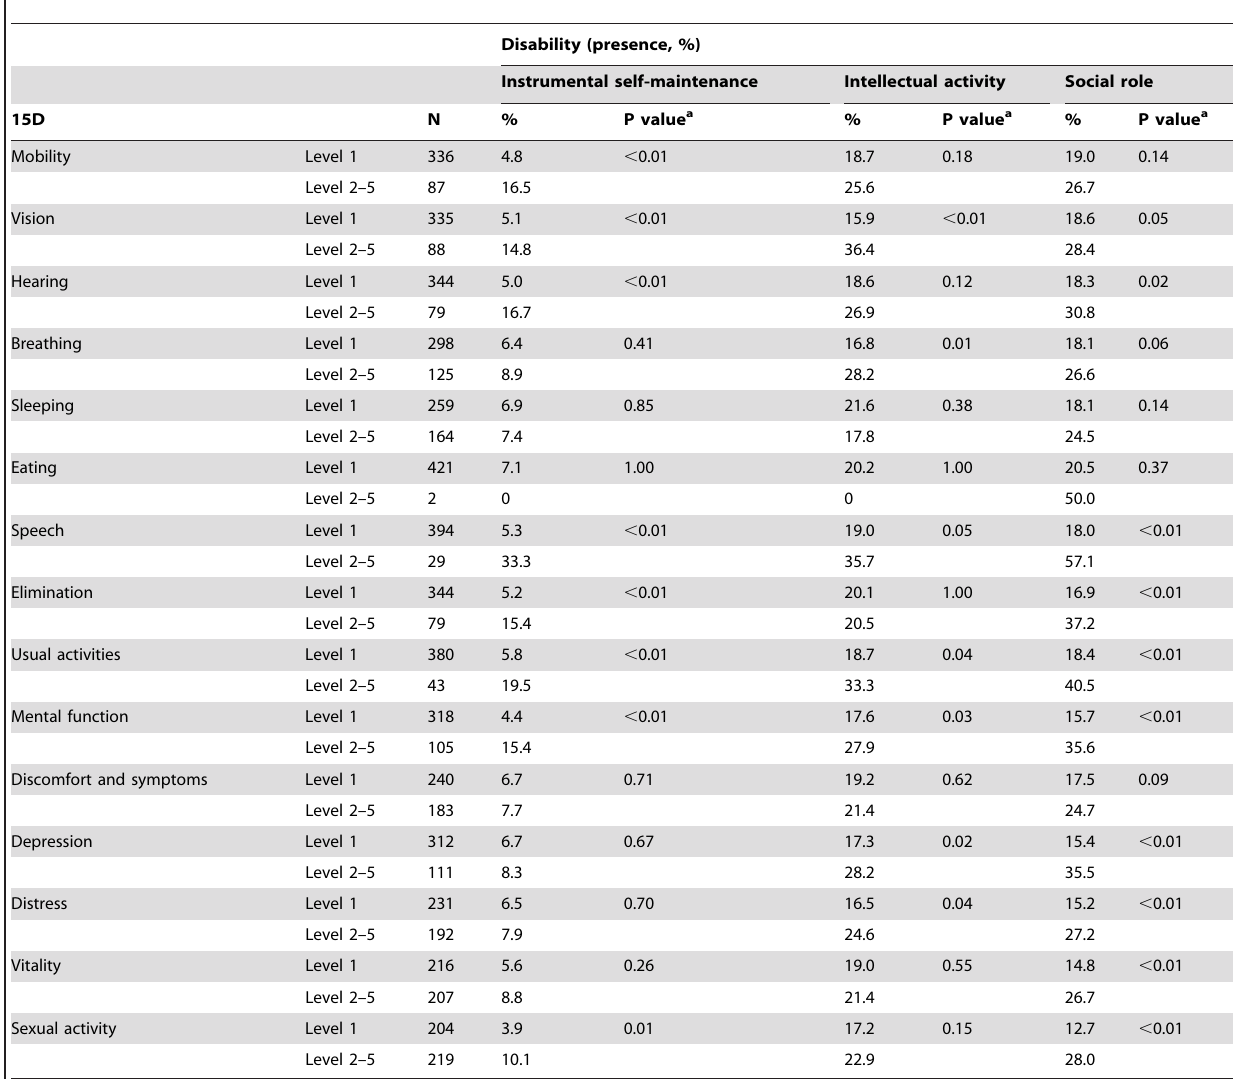
Table 5. Comparison of higher-level functional capacity between ‘‘level 1’’ and ‘‘level 2 to 5’’ in the